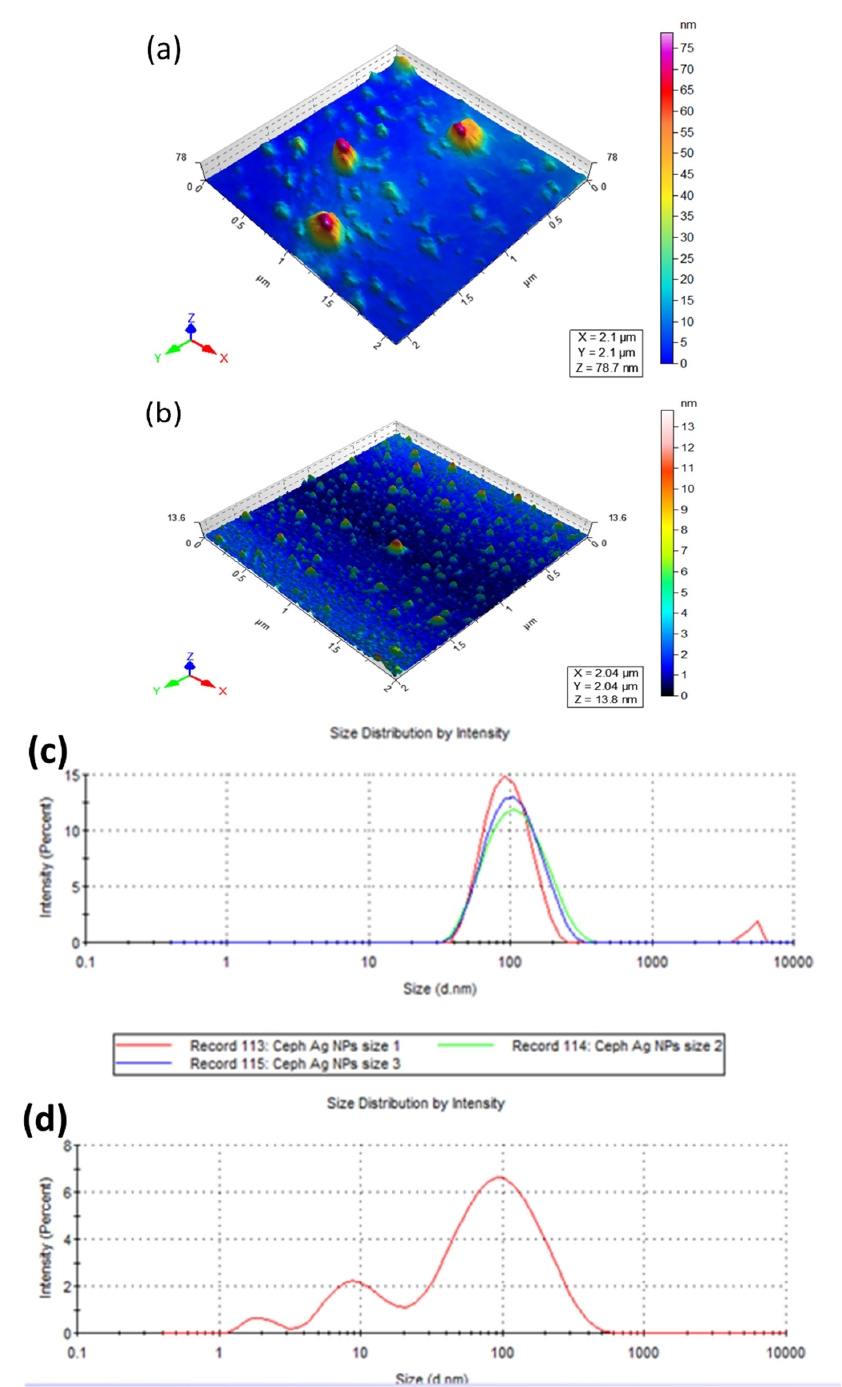
Figure 1. Representative images of atomic force microscopy (AFM) of Ceph-AgNPs ( a ); Vgt-AgNPs ( b ); AFM topographs were recorded on Agilent 5500 instrument used in tapping mode with silicon nitride cantilever. Ceph-AgNPs were found to be 85 nm ( c ); whereas, Vgt-AgNPs with the size distribution of 33 nm as measured by DLS ( d ). Both nanoparticles were spherical and polydisperesed.